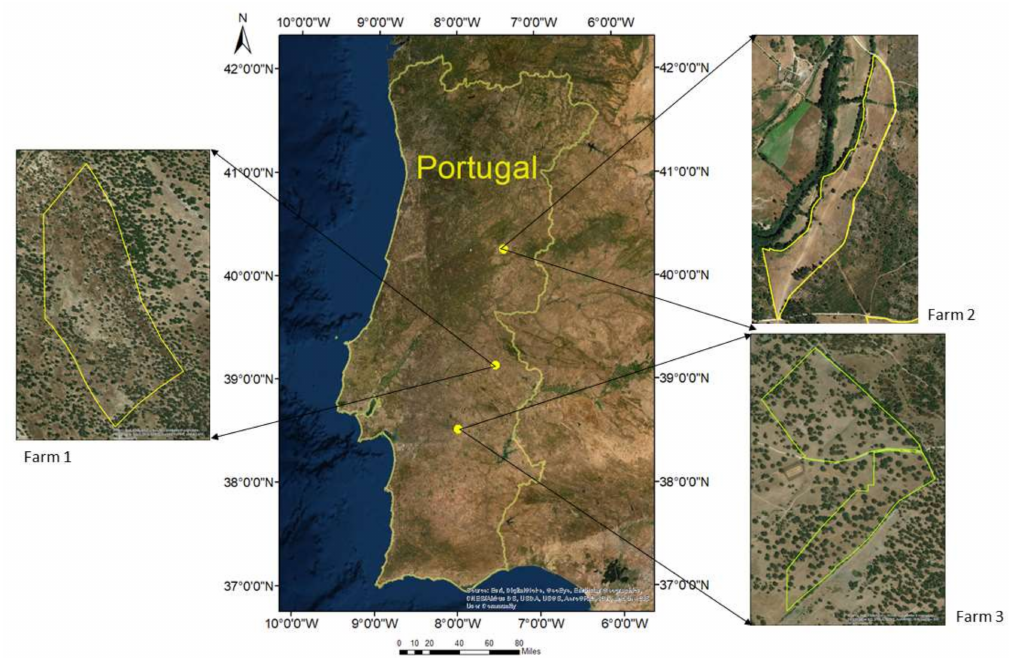
Figure 1. Location of the farms and parcels used in the present study: the limits of the parcels in farm 1 (Monforte municipality, left side), farm 2 (Covilh ã municipality, top right) and farm 3 ( É vora, bottom right) are shown together with the respective aerial image.